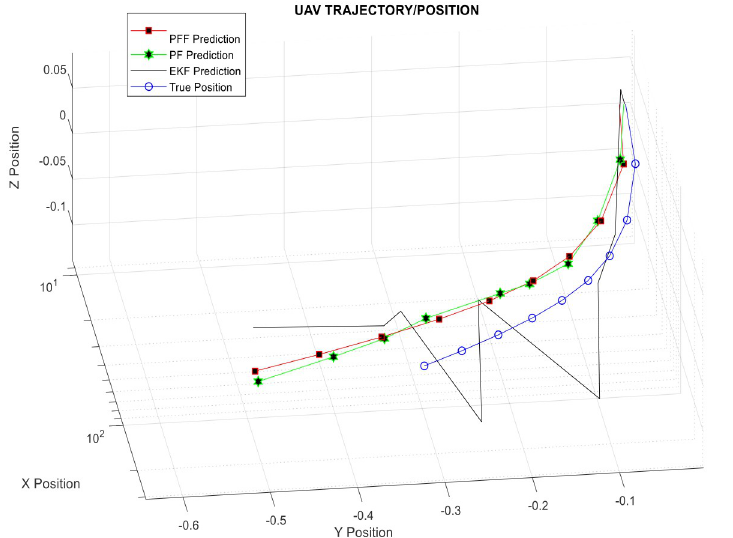
Fig 7. A-SLAM position predictions (zoomed version)—3D.